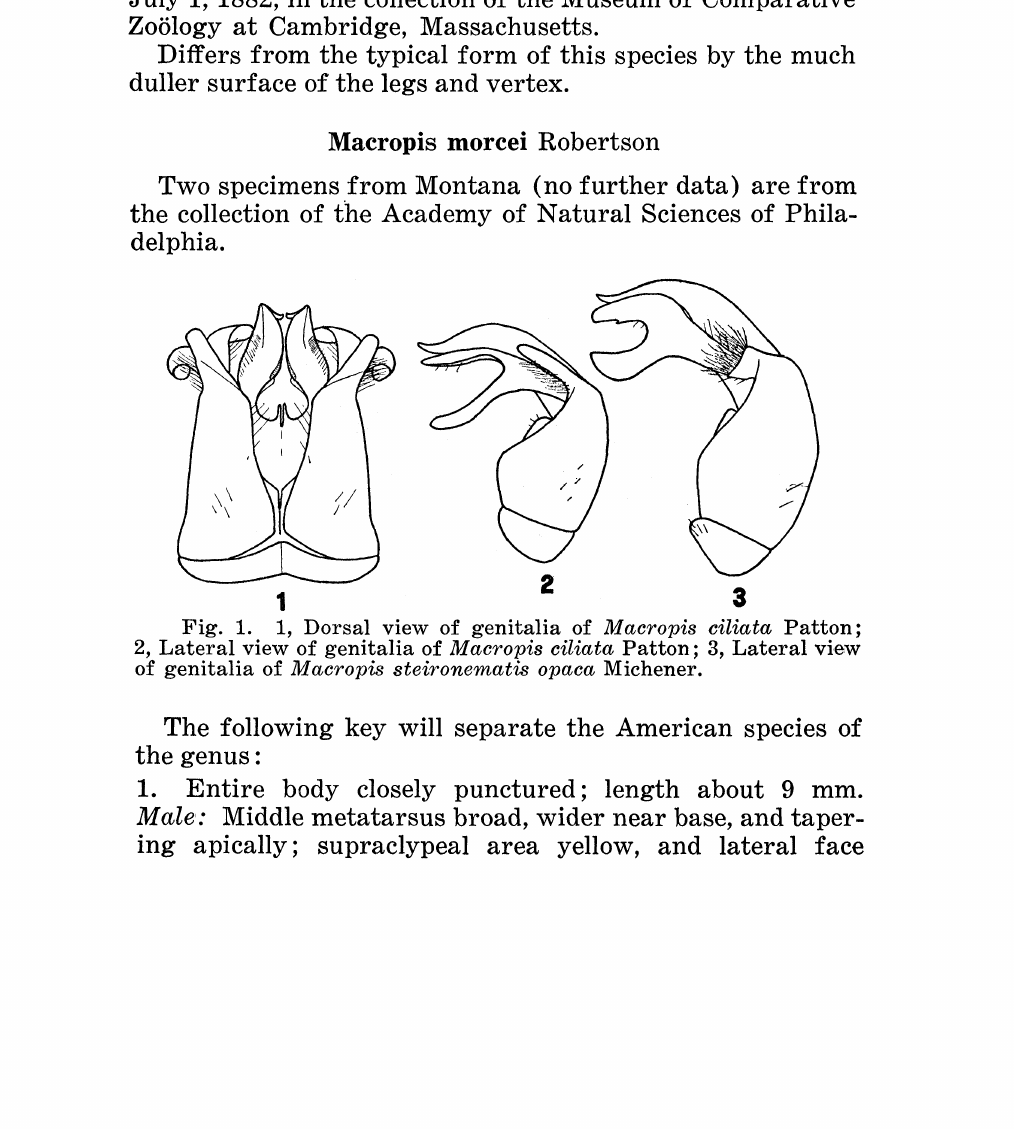
Fig. 1. 1, Dorsal view of genitalia of Macropis ciliata Patton; 2, Lateral view of genitalia of Macropis ciliata Patton; 3, Lateral view of genitalia of Macropis steironematis opaca